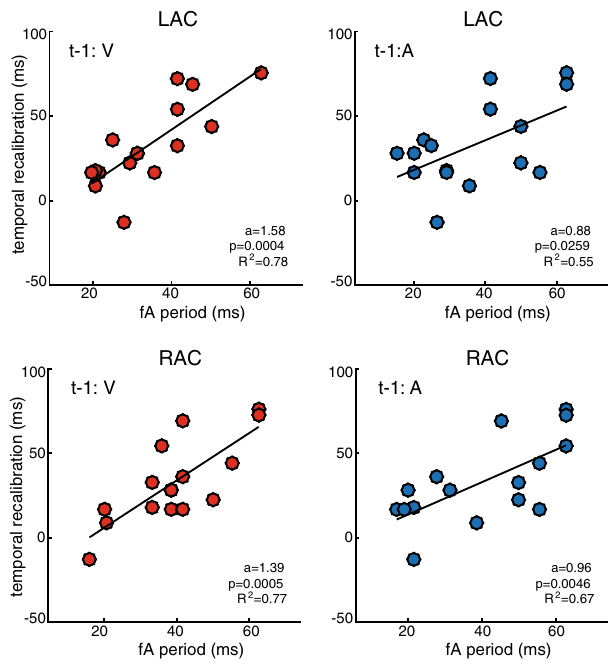
Fig. 5 Temporal recalibration is quantitatively related to fA period. Individual temporal recalibration estimates ( n = 16) are plotted against the observed fA period durations measured over the pre-stimulus period in the auditory cortex for trials with visual (red) and auditory (blue) lead on the previous trial. The dots represent single-subject values. In each panel, the regression line of best fi t is depicted in black. The regression coef fi cients a, p-values, and effect size r 2 are indicated in the respective